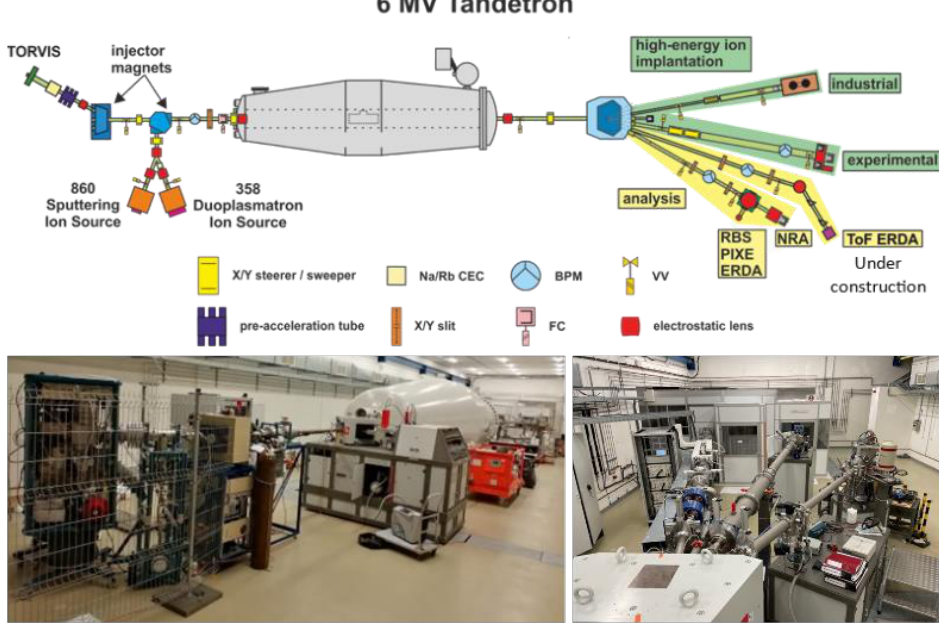
Figure 2. The 6 MV Tandetron ion accelerator at the Advanced Technologies Research Institute, Slovak University of Technology